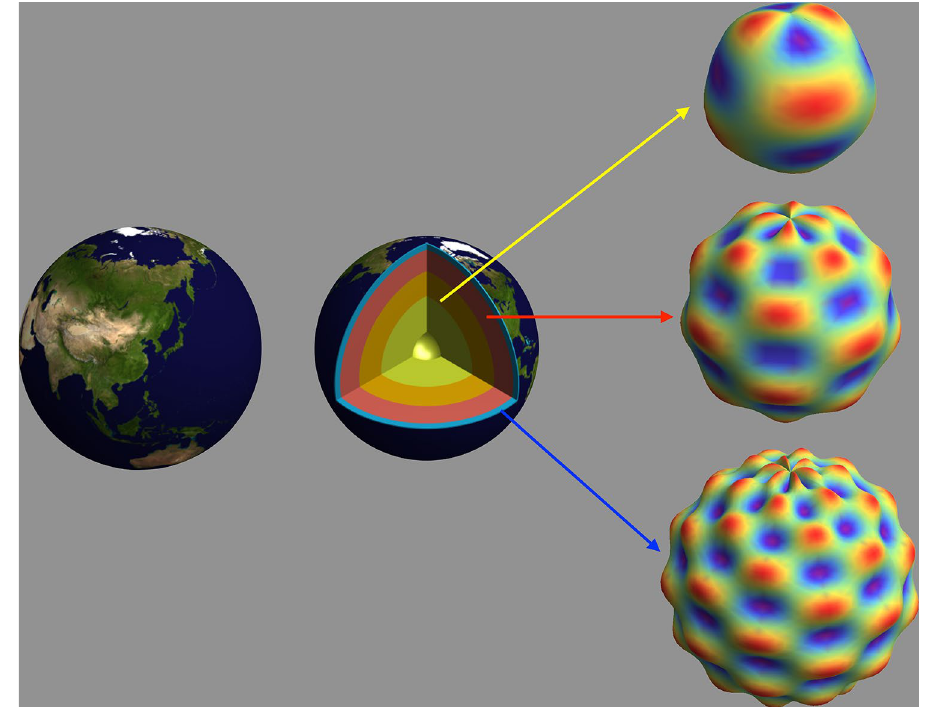
Figure 9. Shape characterization with Spherical Waves. (Left) Schematic of the geological layers of the Earth, each of which is idealized to have a mean spherical shape but complicated surface features (e.g., mountains and valleys on the outer, or crust, layer). (Right) Schematic of spherical waves fit to each layer consisting of variations in both the radial and angular dimensions. No data was actually fit, and the features size is greatly exaggerated for emphasis. In this example the complexity of the surface is presumed to increase with radius just for illustrative purposes. Only the surfaces of each layer has been “fit” for clarity but in practice a continuum of fits over all radial values is